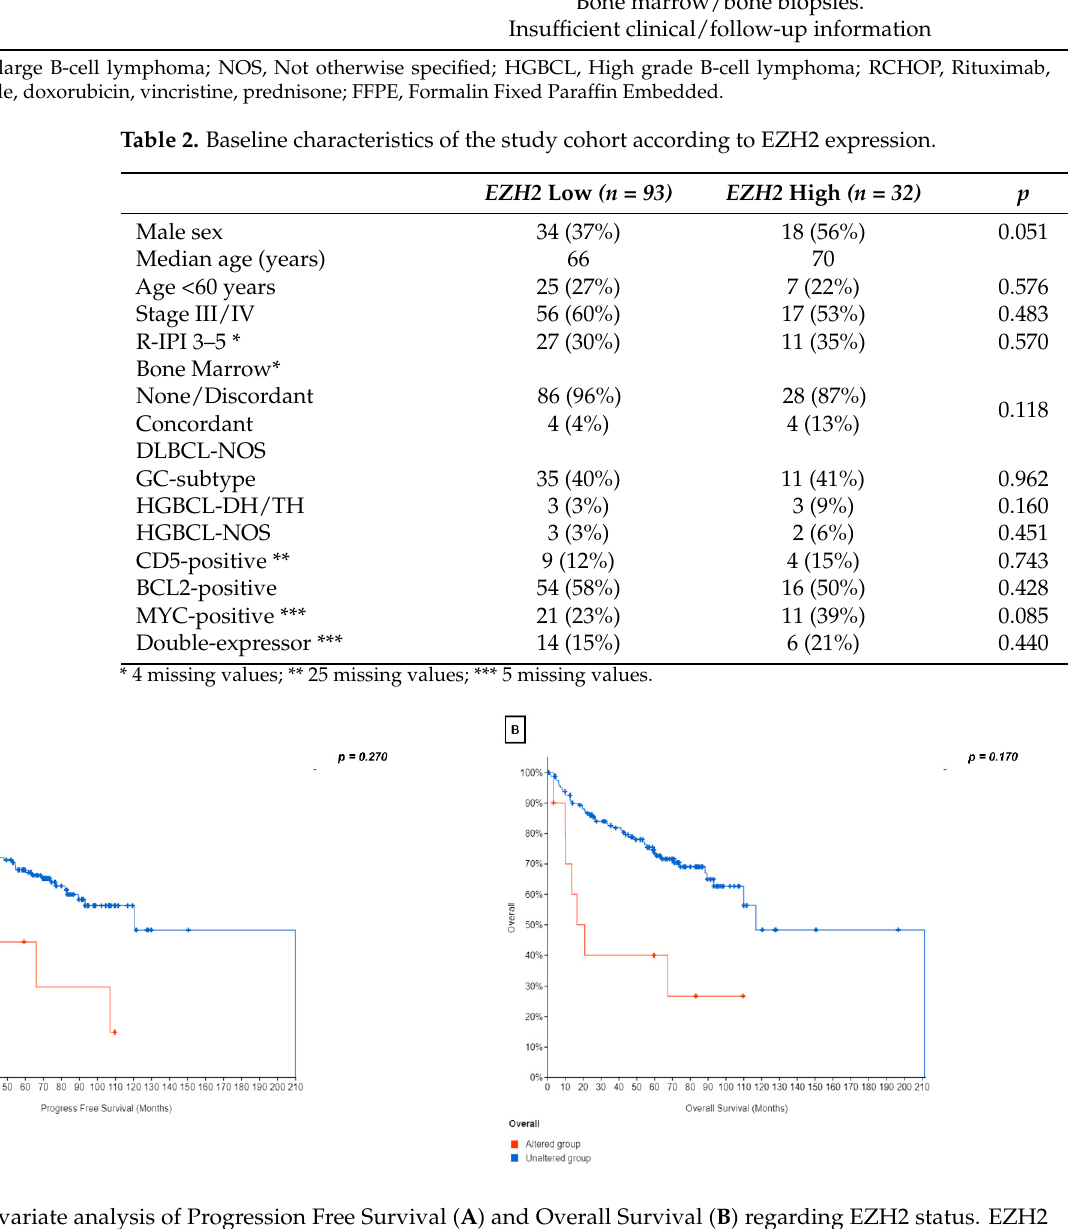
Table A2. Baseline characteristics of the study cohort according to EZH2 expression.